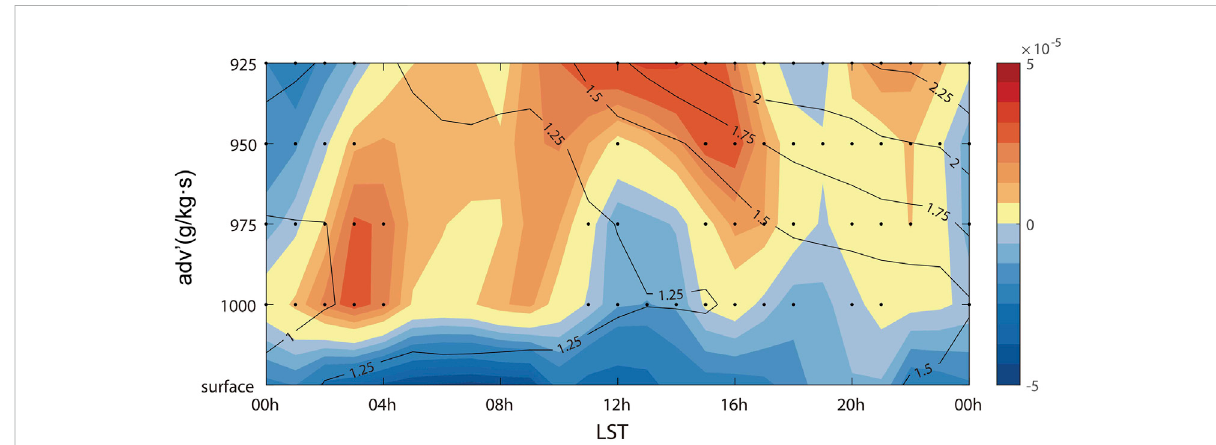
FIGURE 8 Compositeresultsofanomalousmoistureadvection(g/kg · s;shading)attheQingdaoregionfromthesurfaceto925 hPaduringday0basedon